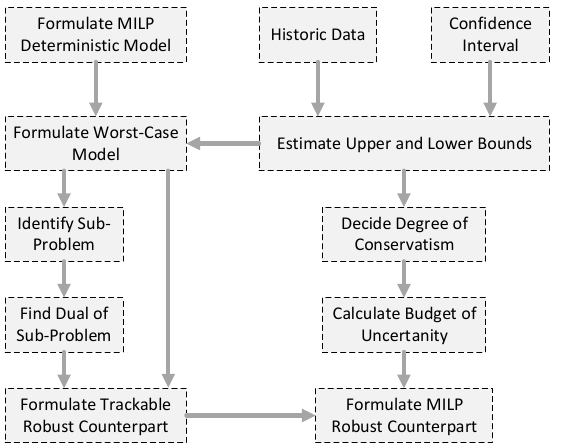
Figure 2. Problem formulation process of robust optimization.